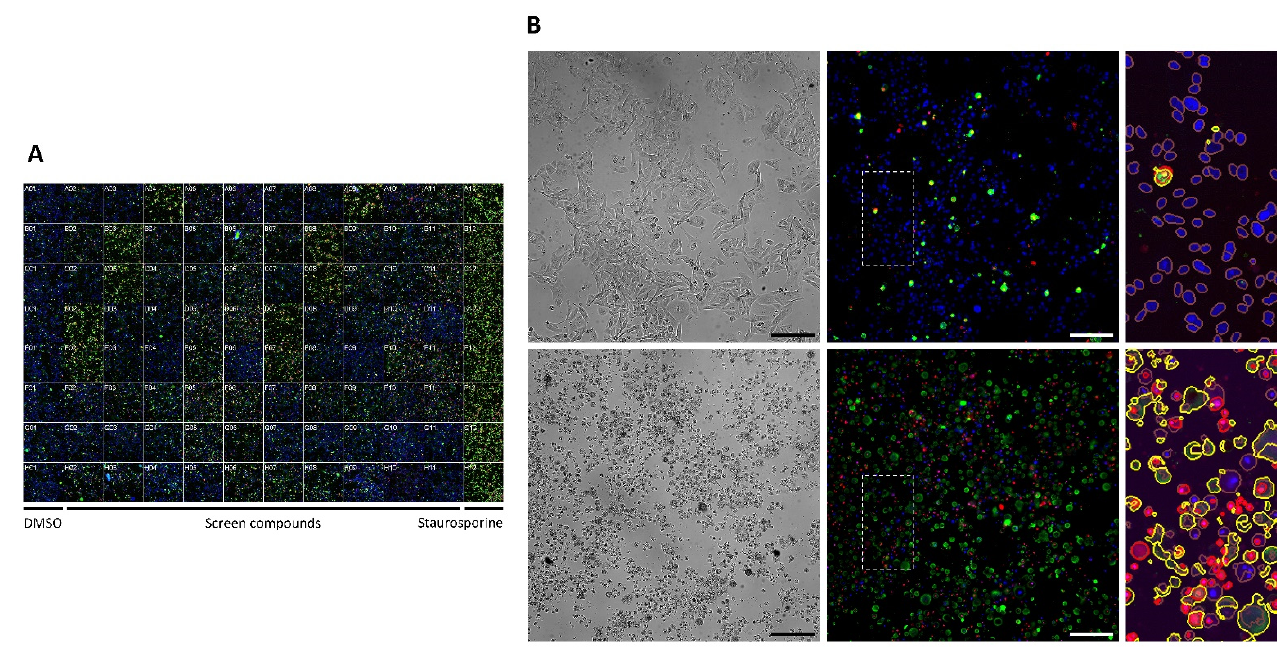
Figure 2. Annexin V apoptosis assay screen. ( A ) Full plate snapshot example of the Annexin V screen with CM2005.1 cells, composed of 8 replicates of each of the controls and 80 screen compounds, montaged together. All nuclei are stained blue with Hoechst, apoptotic cells green with Annexin V, and dead nuclei red with Ethidium homodimer-1. Objective 10 × /0.45. The snapshot is composed of a single field of view out of the 9 fields acquired per well. ( B ) Example images of the control conditions for CM2005.1 cells. Top: DMSO. Bottom: Staurosporine. Left panel: brightfield images. Middle panel: fluorescent images acquired as in A. Right panel: zoomed crop of the area highlighted by a dashed rectangle, with an overlay of image segmentation performed by CellProfiler. Brown: all nuclei. Yellow: Annexin V-positive apoptotic cells. Red: dead Ethidium homodimer-1 positive nuclei. Scale bar 200 µm.